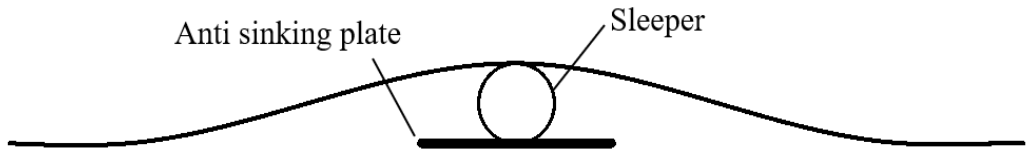
Figure 1. Sketch map of the sleeper